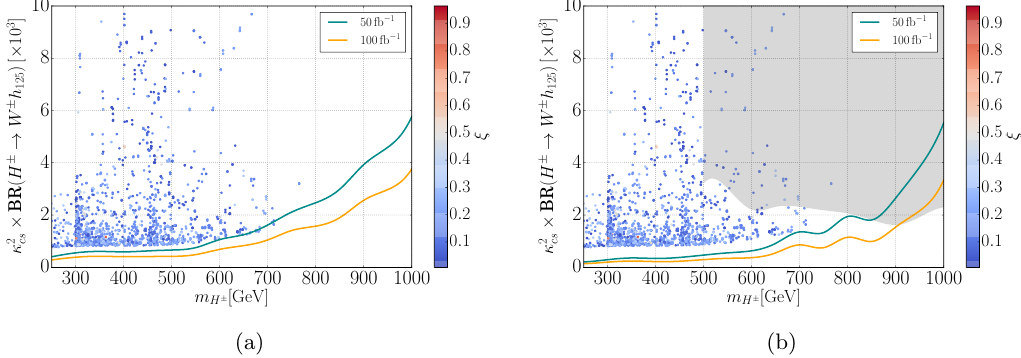
Figure 5 . The 5 (cid:27) discovery contours of (cid:20) 2 = 50 ; 100 fb (cid:0) 1 at the LHC ( p s = 13 TeV) for (a) 1 b -tag category and (b) 2 b -tag category. The L dots represent the parameter points resulting form the GA scan with the corresponding values of (cid:24) encoded in their